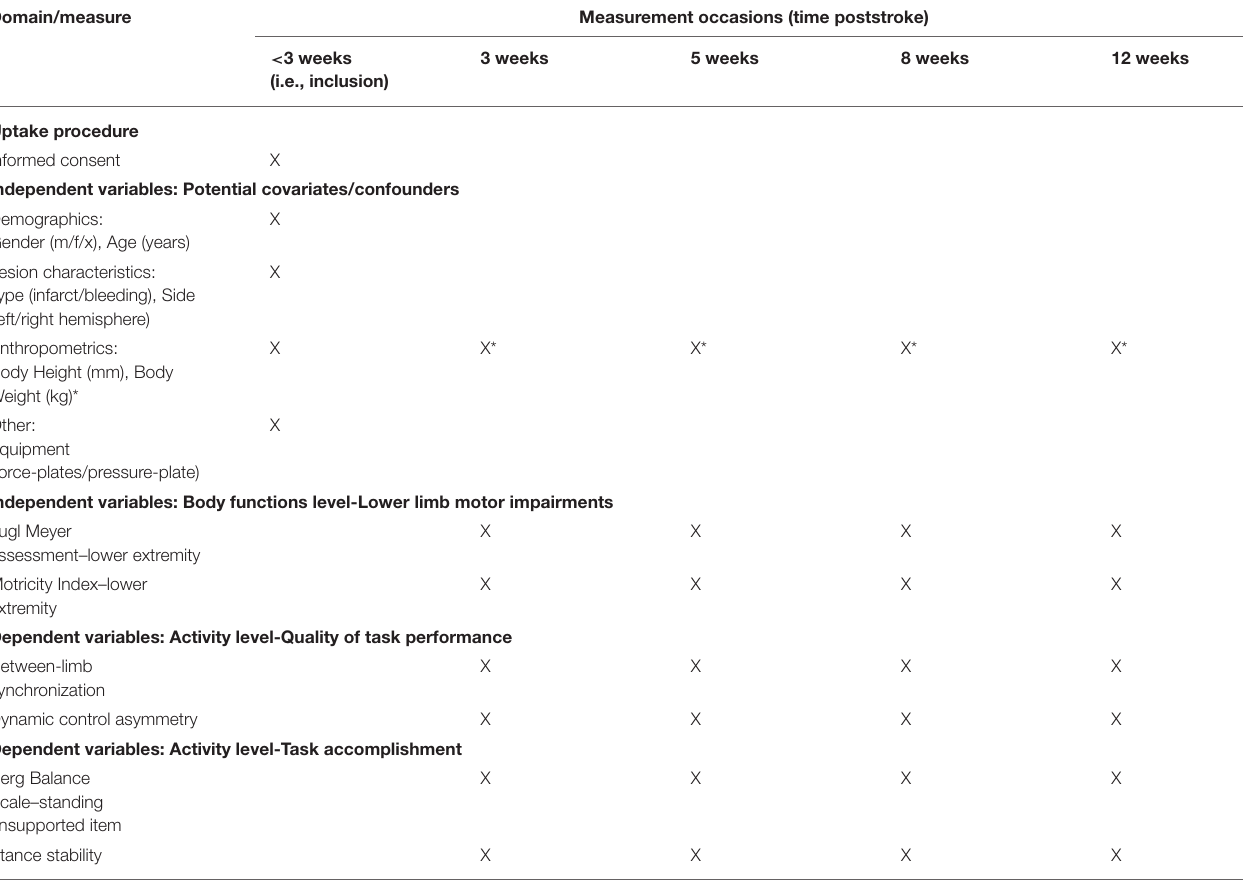
TABLE 1 | Measurements per assessment occasion.